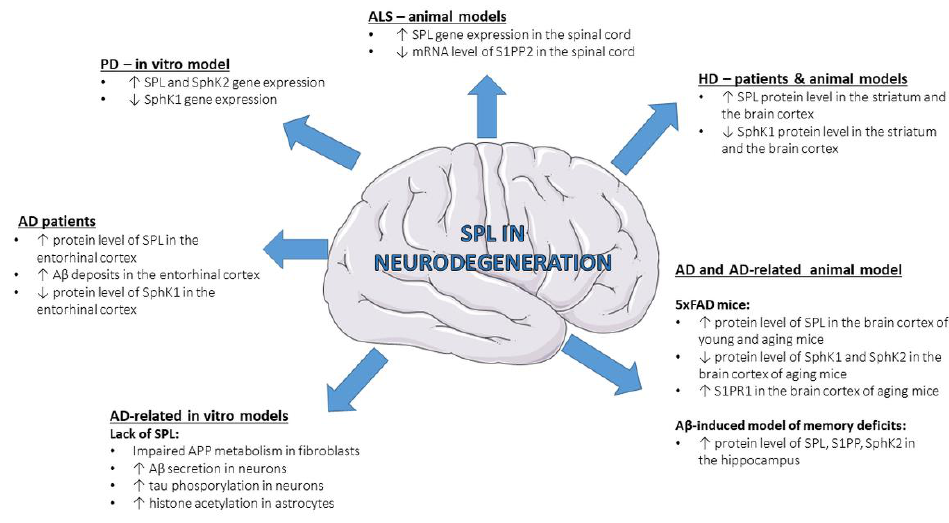
Figure 2. Changes in SPL and other S1P-metabolizing enzymes in neurodegenerative diseases—state-of-the-art data from patients and experimental models. A β —amyloid β peptide; AD—Alzheimer’s disease; ALS—amyotrophic lateral sclerosis; HD—Huntington’s disease; S1PP—sphingosine-1-phosphate phosphatase; PD—Parkinson’s disease; S1PP2—sphingosine-1-phosphate phosphatase 2; S1PR1—S1P receptor 1; SphK1—sphingosine kinase 1; SphK2—sphingosine kinase 2; SPL—sphingosine-1-phosphate lyase.